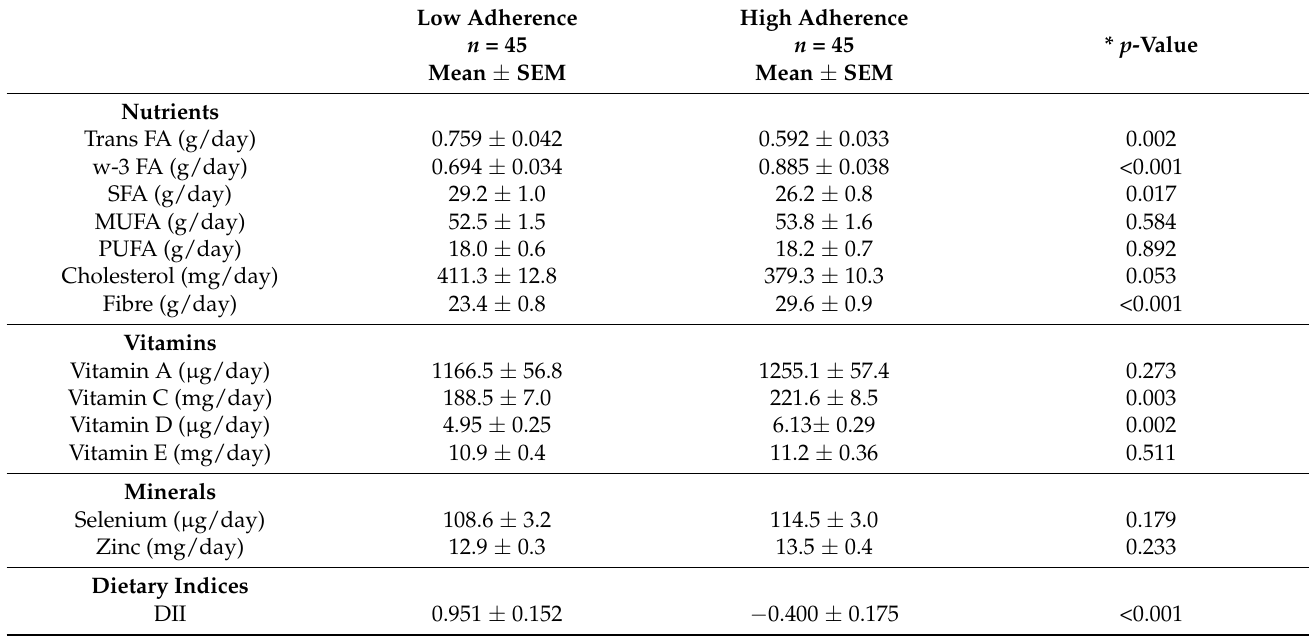
Table 2. Nutrients, vitamins, and minerals ingested by participants according to median values of adherence to the Mediterranean Diet Pattern.